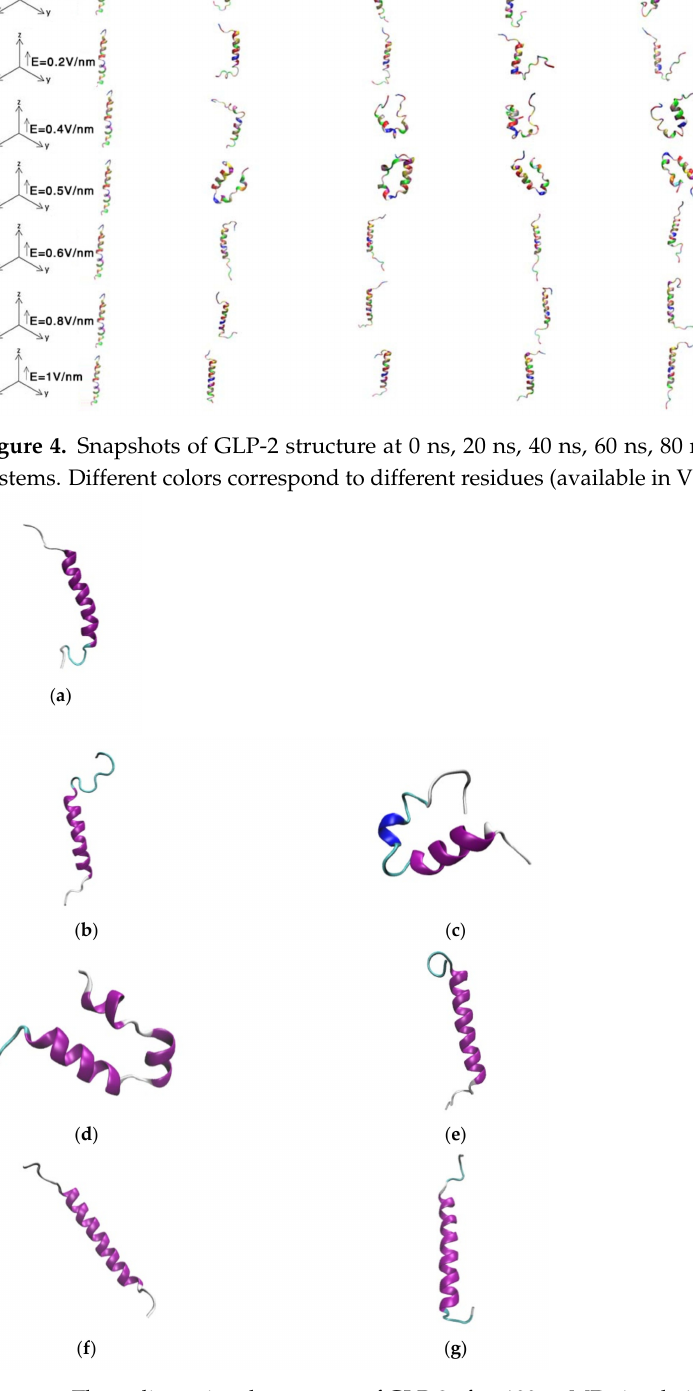
Figure 5. Three-dimensional structures of GLP-2 after 100 ns MD simulations. The structures without external electric field ( a ) and under the external electric field of 0.2 V/nm ( b ), 0.4 V/nm ( c ), 0.5 V/nm ( d ), 0.6 V/nm ( e ), 0.8 V/nm ( f ) and 1 V/nm ( g